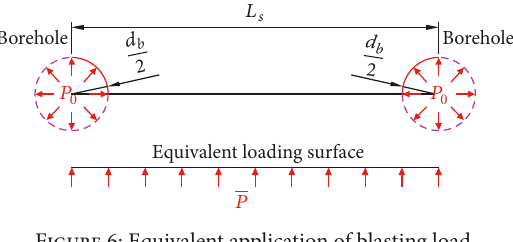
Figure 6: Equivalent application of blasting load.